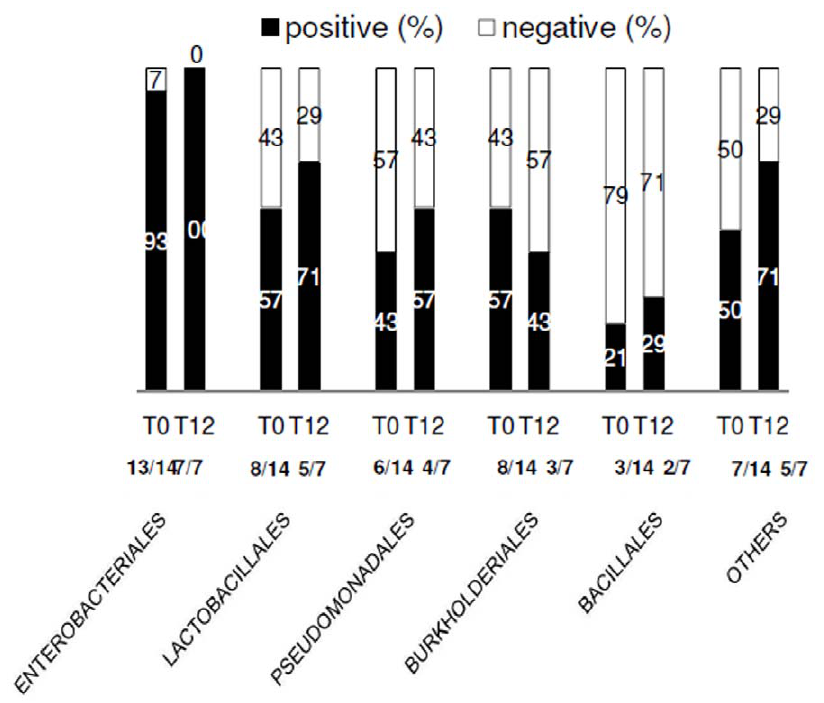
Figure 1. Characterization of translocating microflora in HIV + antiretroviral naive patients. Patients’ plasma samples were examined before and after 12 months of HAART for the presence and identification of DNA bacterial fragments using a broad-range 16S rRNA gene PCR amplification followed by sequencing analysis. At baseline, 14/44 (32%) HIV + patients yielded a positive PCR amplification, whereas at T12, 7/44 (16%) HIV + patients were PCR-positive. Sequencing analysis of HIV positive patients as a whole revealed multiple bacterial orders for each patient with no differences in the bacterial composition between baseline and T12. Positive (%)= # patients displaying a specific bacterial order/total # of PCR positive patients. Negative (%)= # patients negative for a specific bacterial order/total # of PCR positive